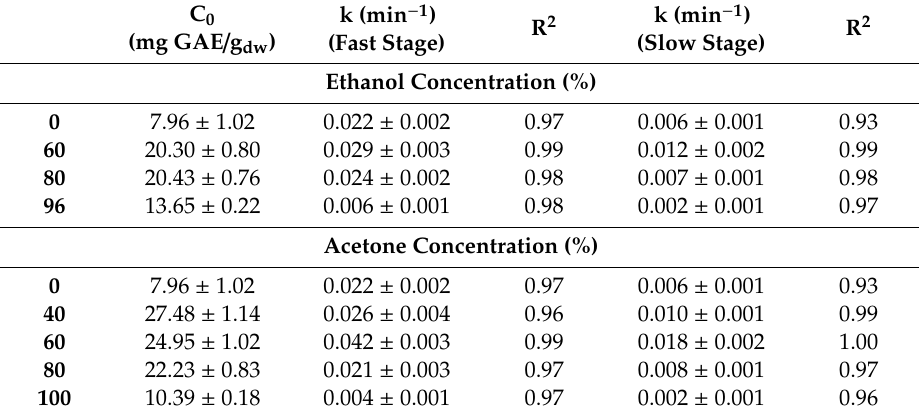
Table 1. The initial concentration of phenolics in the solvent (C 0 ) and the rate constant (k) of each extraction step, performed by di ff erent aqueous solutions of ethanol or acetone, at 22 ◦ C, solid-to-liquid ratio 1:20, and non-specific particle size, as calculated by fitting Equation (1). The correlation coe ffi cients (R 2 ) are also presented. C 0 (mg GAE / g dw